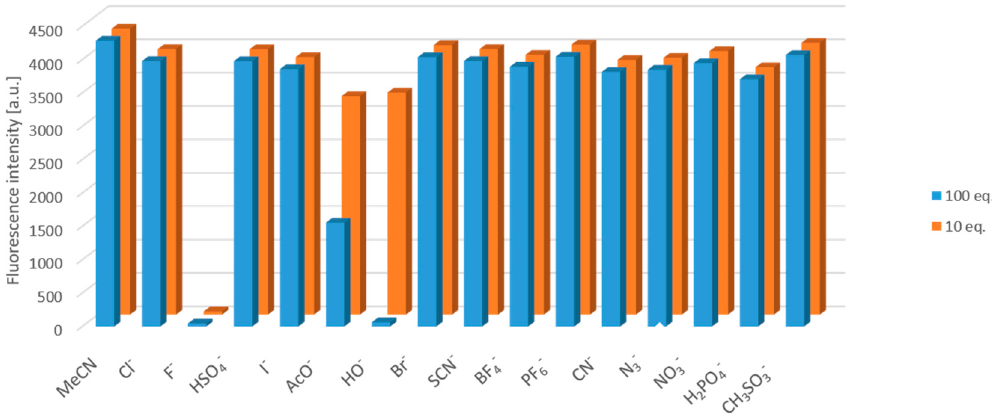
Figure 4. Fluorescence intensity changes caused by the anions at the wavelength of the maximal intensity after 5 min.